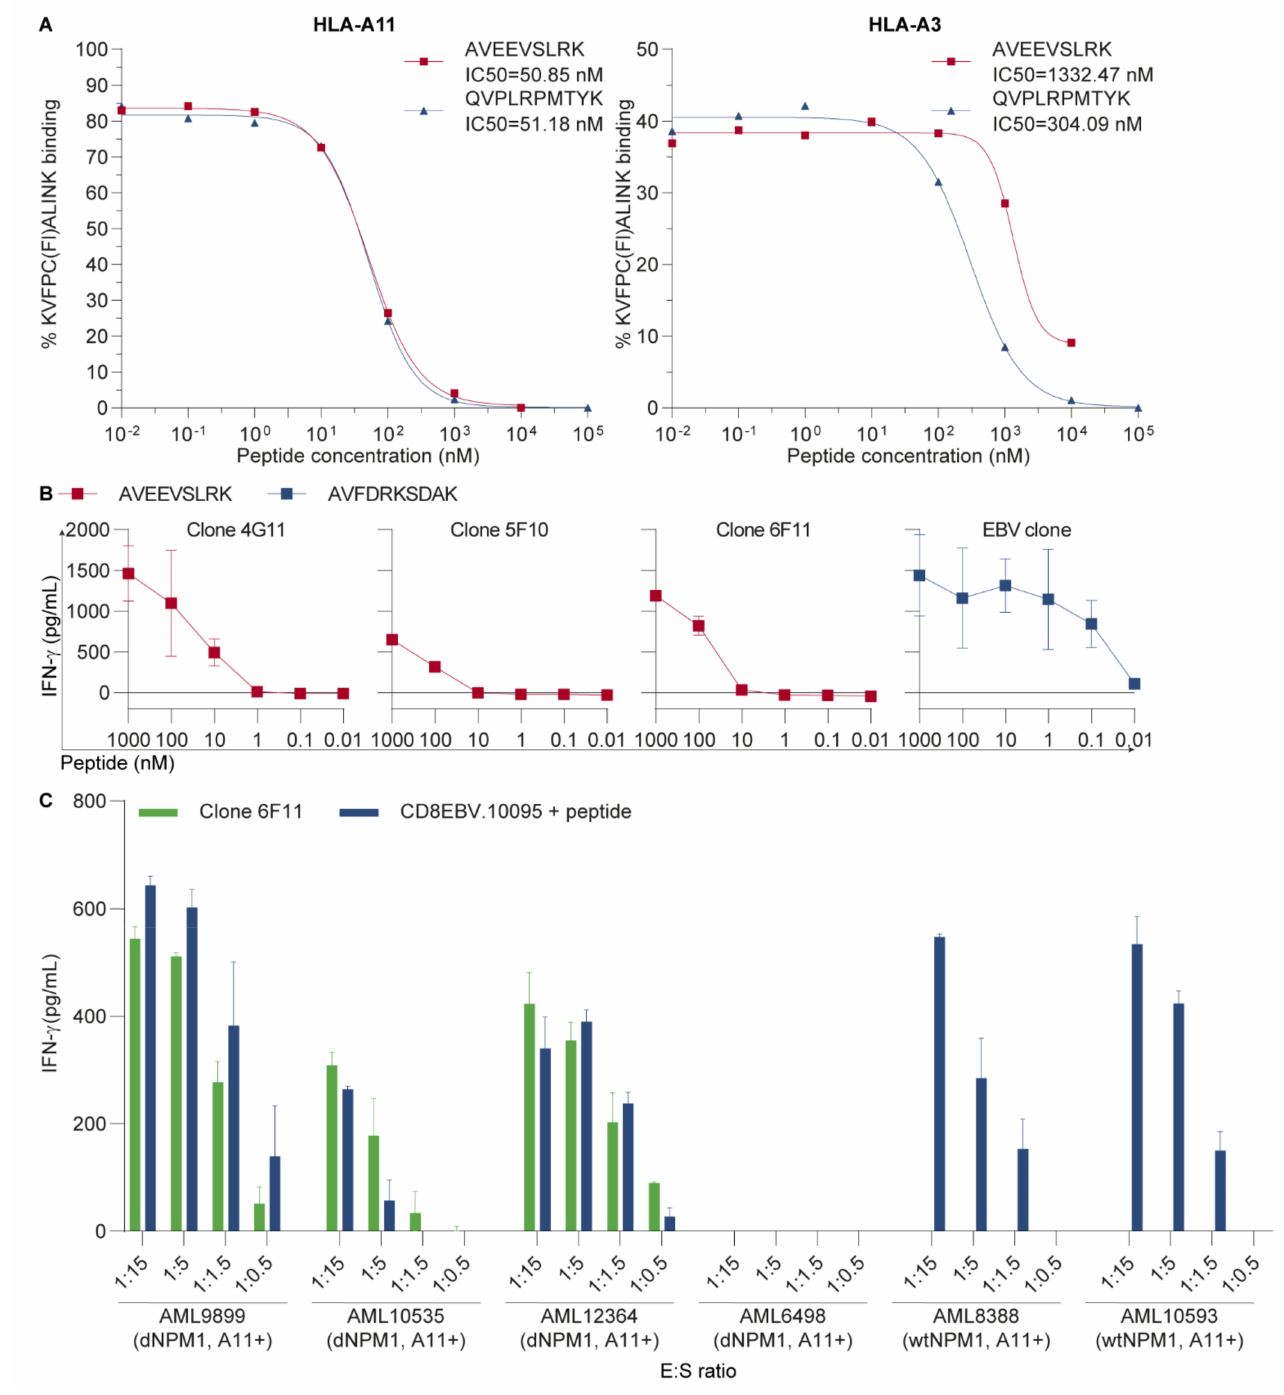
Figure 1. Clone 6F11 specifically recognizes dNPM1-derived AVEEVSLRK in HLA-A11. ( A ) Affinity of AVEEVSLRK for HLA-A*11:01 (HLA-A11) (left panel) and -A*03:01 (-A3) (right panel) was measured by a competition-based peptide- HLA class I binding assay in which fluorescein-labeled KVFPC(Fl)ALINK and soluble HLA-A11 or -A3 were added to 10-fold dilutions of AVEEVSLRK (red line and squares) or QVPLRPMTYK (blue line and triangles), which is an human immunodeficiency virus (HIV) positive control peptide that binds to HLA-A11 as well as HLA-A3. After overnight incubation, fluorescence was measured by HPLC with a fluorescence detector and % binding of KVFPC(Fl)ALINK was calculated. High-affinity binding was observed for AVEEVSLRK in HLA-A11 with an IC50 of 51 nM, which is similar to the IC50 of 51 nM for the positive control. Binding of AVEEVSLRK to HLA-A3 was lower, with an IC50 of 1332 nM as compared with the positive control with an IC50 of 304 nM; ( B ) Peripheral blood mononuclear cells (PBMCs) from HLA-A11+